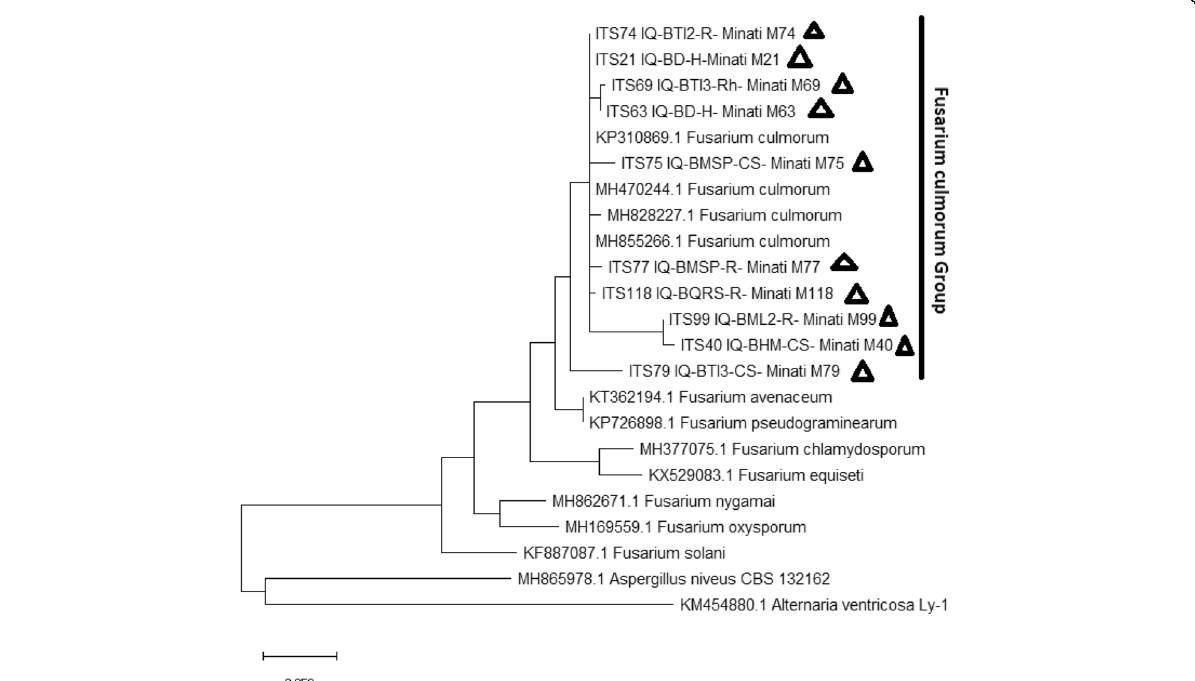
Fig. 8 Phylogenetic tree generated with the ITS-rDNA sequences of the Fusarium culmorum (10), as inferred from the maximum likelihood (ML) analyses (determined by black triangles) and related species retrieved from GenBank. ITS sequences of Aspergillus niveus (MH865978) and Alternaria ventricosa (KM454880) were used as the out-group species